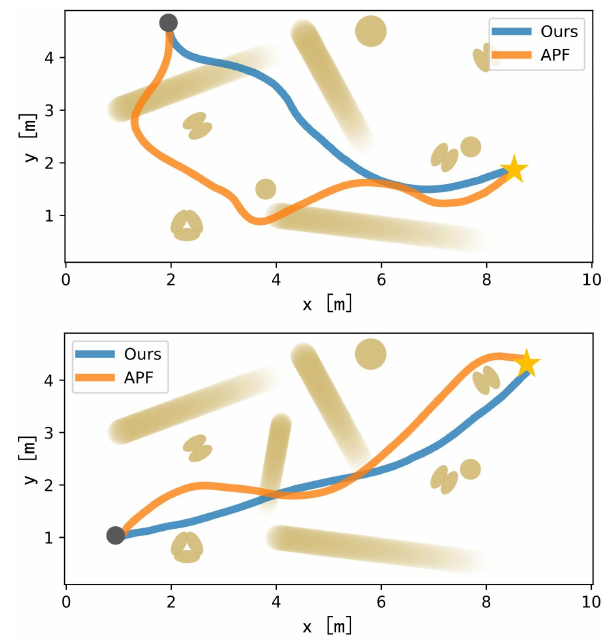
Figure 18. Trajectories in the dynamic